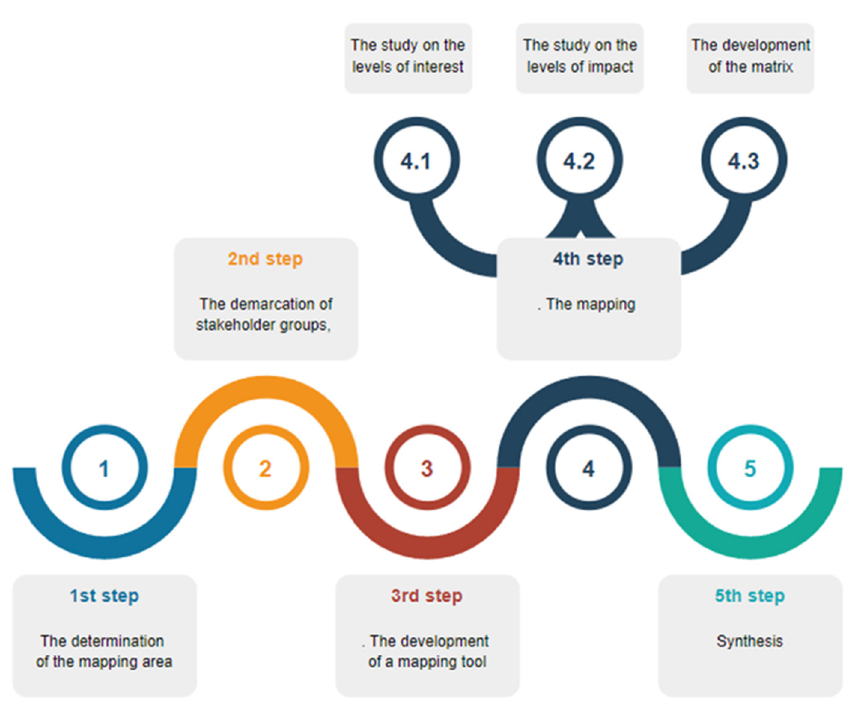
Figure 1. The algorithm proposed for the mapping of local stakeholders. Source: the authors’ own study.